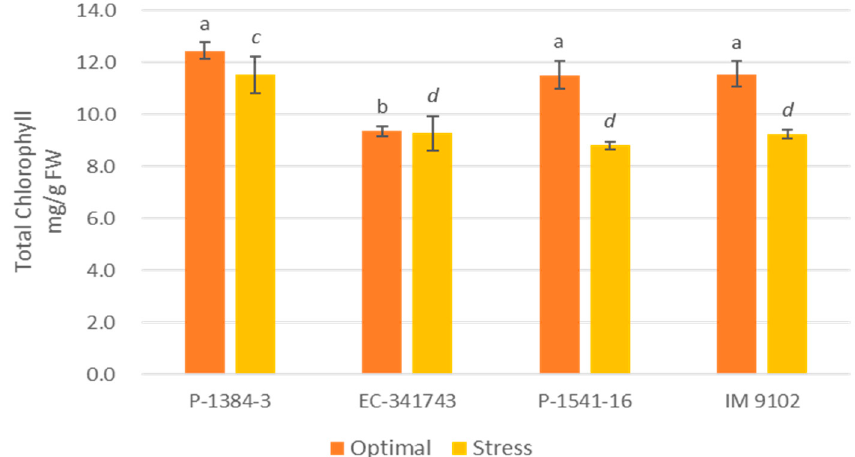
Figure 3. Total chlorophyll content of four field pea genotypes under optimal and heat stress. Columns with different letters indicate significant difference at p ≤ 0.05 (Fisher LSD test).